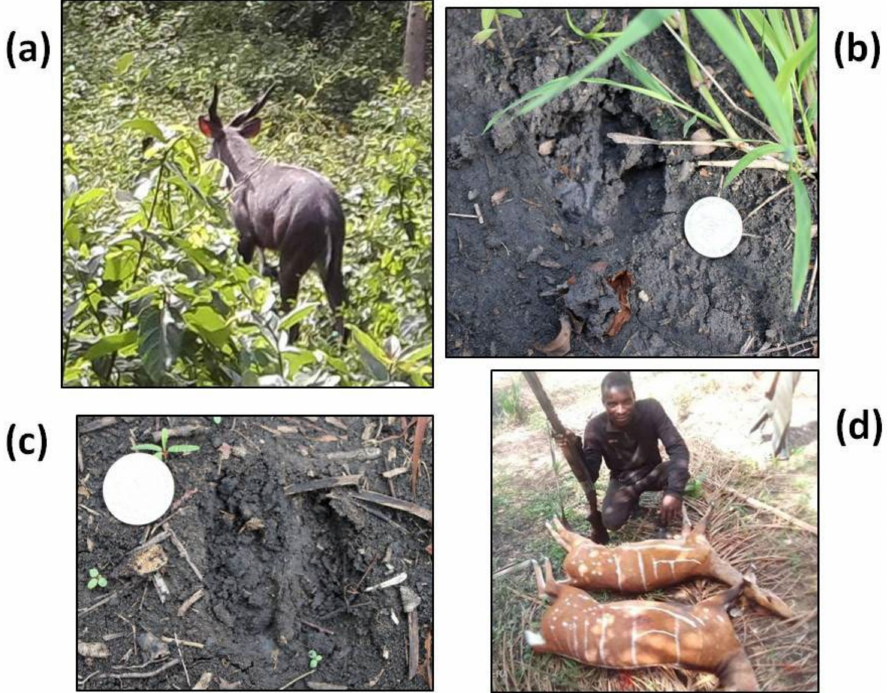
Plate 1. Images of two species of ungulates from the study area: ( a ) Tragelaphus spekii male; ( b ) Trage- laphus spekii footprint; ( c ) Tragelaphus scriptus footprint; ( d ) a hunter with two Tragelaphus scriptus